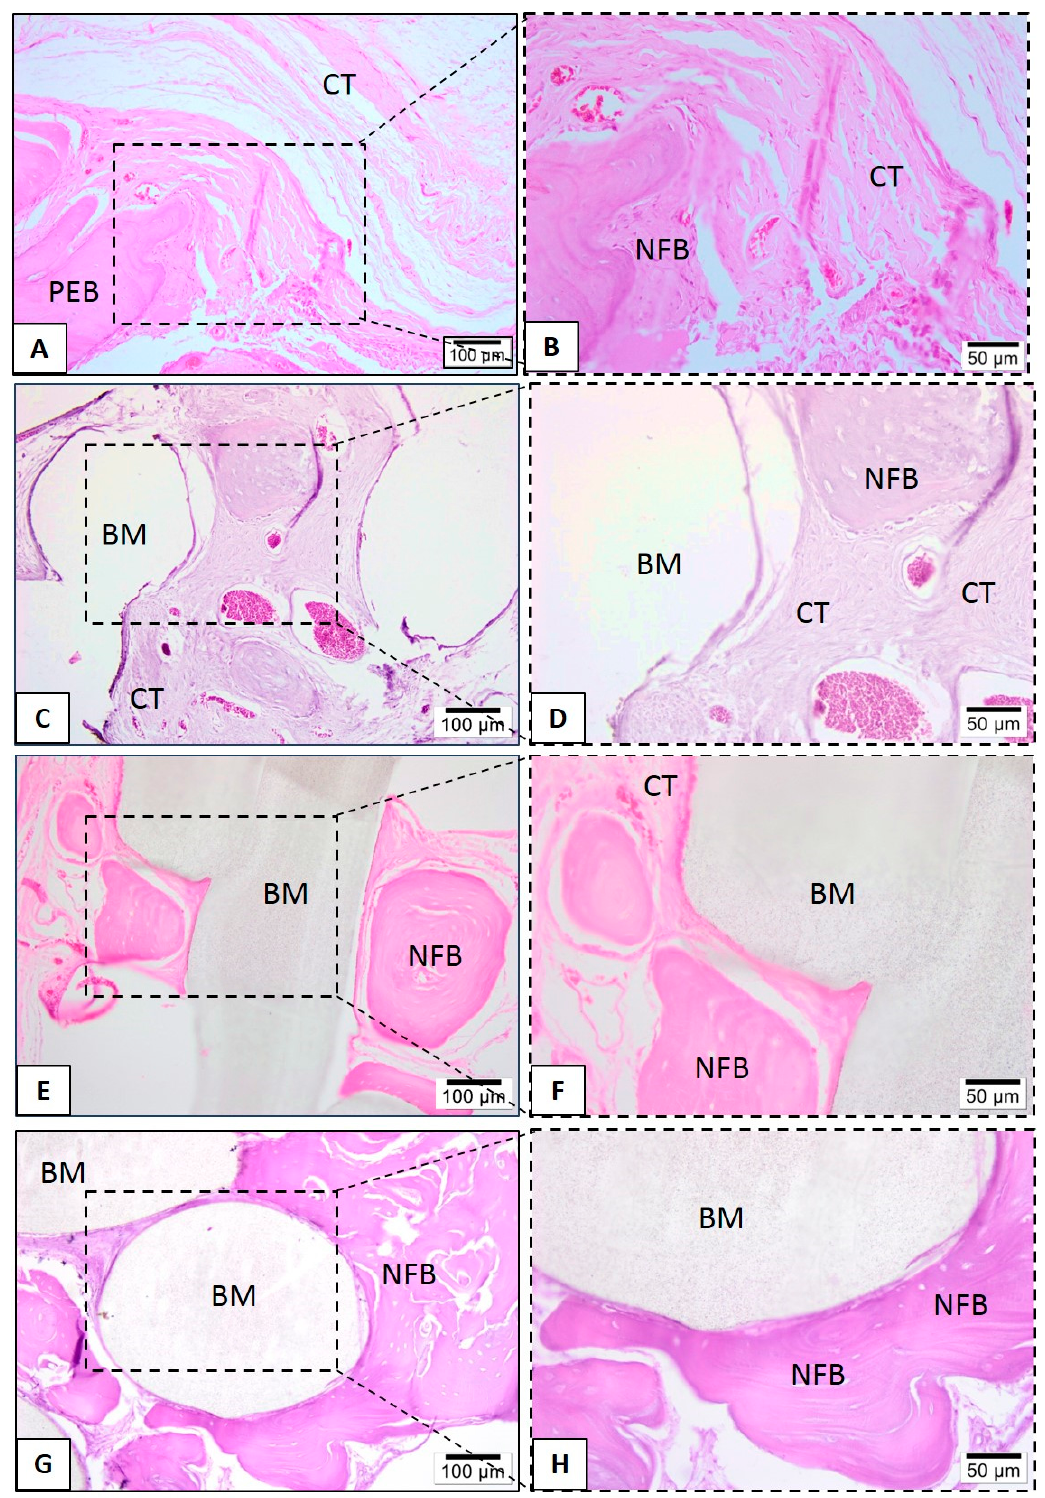
Figure 11. Representative photomicrographs of calvaria defect after 3 month. Histological section stained with hematox- ylin/eosin from the region of control without biomaterial ( A , B ), biomaterial implantation in the PLA ( C , D ), PLA-CaP ( E , F ) and PLA-CaP-rhBMP-2 ( G , H ) groups—3 month after implantation. The region occupied by pre-existing bone is indicated with (PEB), newly formed bone (NFB); connective tissue (CT) and biomaterial/PLA scaffold (BM). Results are representa- tive of 5 rat/group.